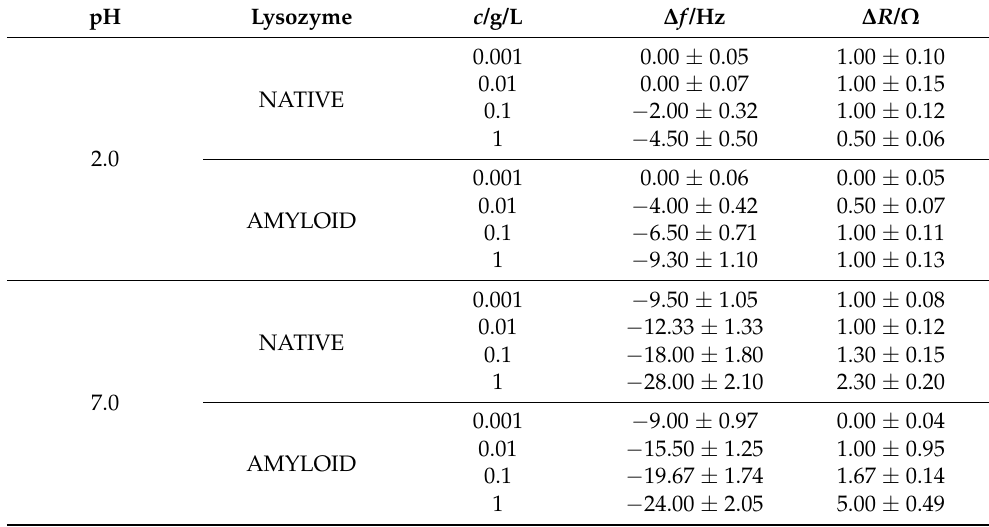
Table 2. Frequency ( ∆ f ) and resistance changes ( ∆ R ) determined by QCM measurement during adsorption of lysozyme at various concentrations and